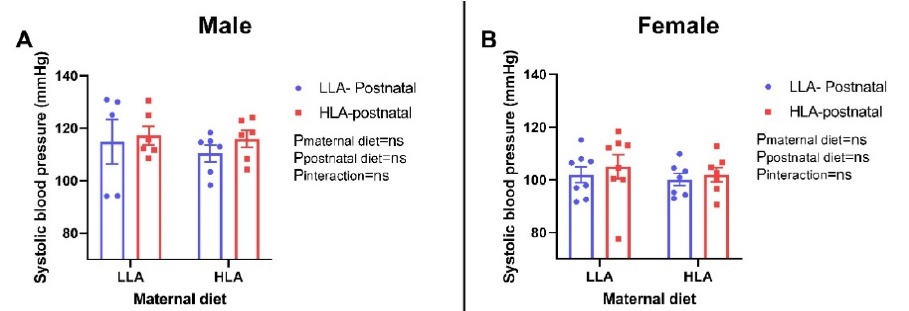
Figure 2. Effect of a maternal and postnatal diet high in linoleic acid on systolic blood pressure of adult offspring. Data are presented as mean ± standard error of the mean (SEM). Two-way ANOVA was performed for statistical analysis with maternal diet and postnatal diet as two factors. n = 5–8. LLA: low linoleic acid; HLA: high linoleic acid; PN: postnatal. A : Systolic blood pressure males; B : Systolic blood pressure females